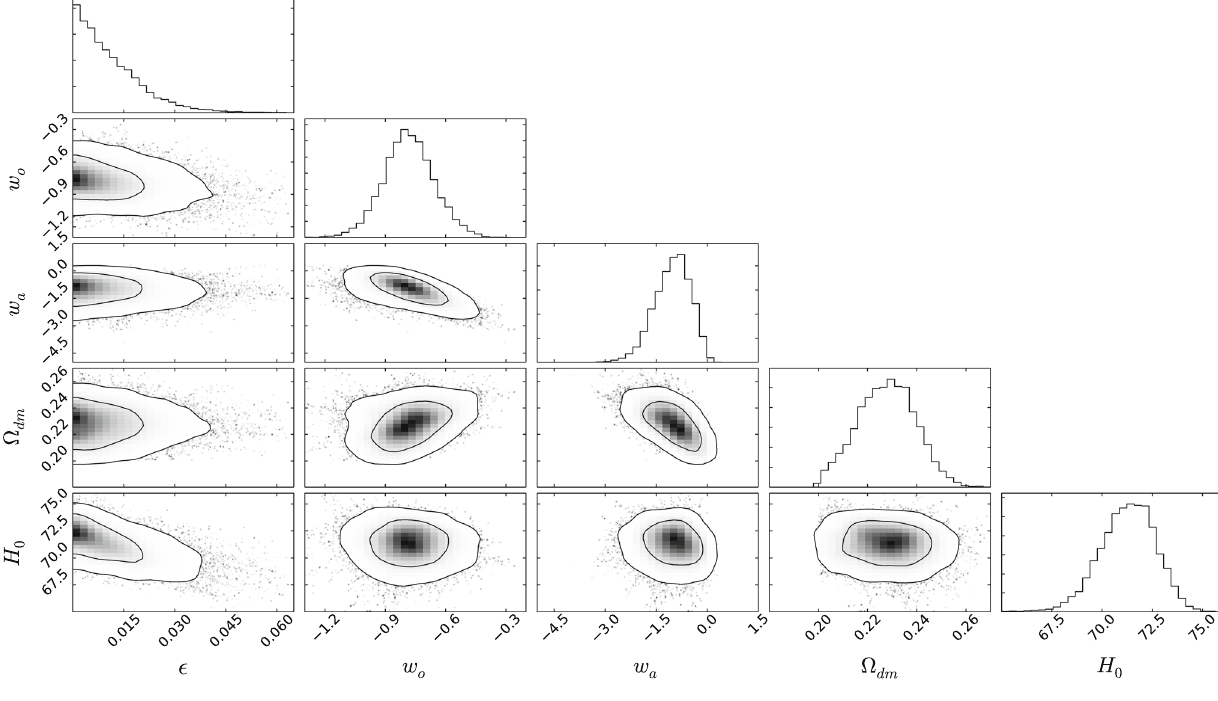
allowed. We fix the baryon content at the Planck Collabora- tion value (cid:8) b h 2 = 0 . 02226. The radiation density param- eter used is (cid:8) r = 4 . 15 × 10 − 5 h − 2 and the photon